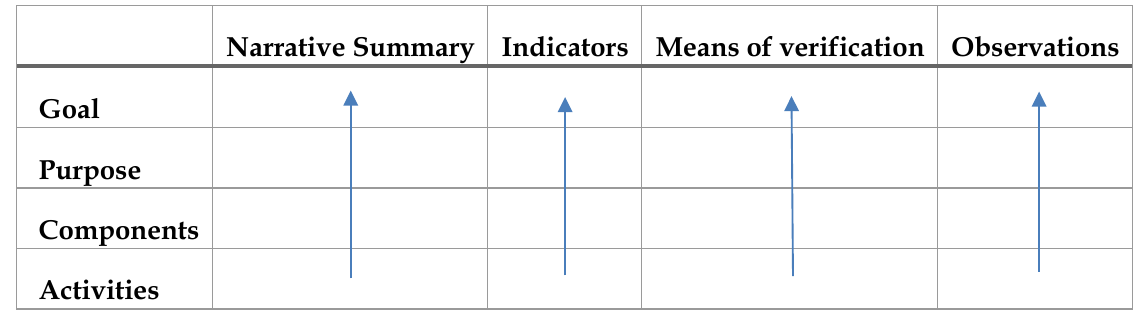
Table 2: Vertical Logic